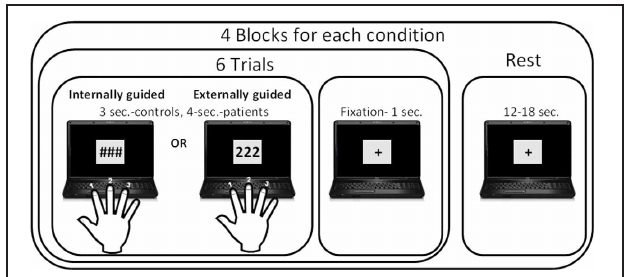
FIGURE 1 | Finger tapping paradigm. Participants were instructed to tap a finger three times according to the visual stimuli: in the externally guided condition they selected a finger according to the number presented, while in the internally guided condition they had free choice of which finger to tap in each